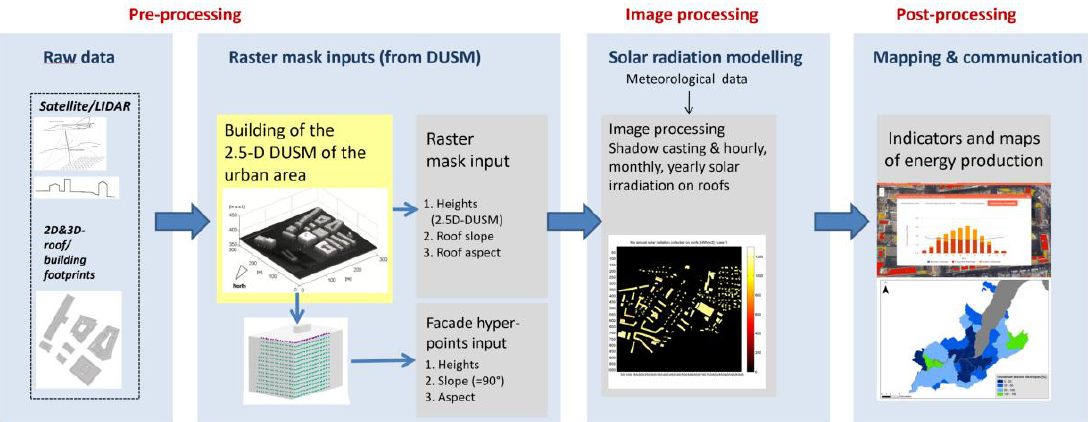
Figure 1. The entire process of solar modelling and mapping from raw data acquisition to solar mapping. Adapted from [12]. DUSM: digital urban surface model.